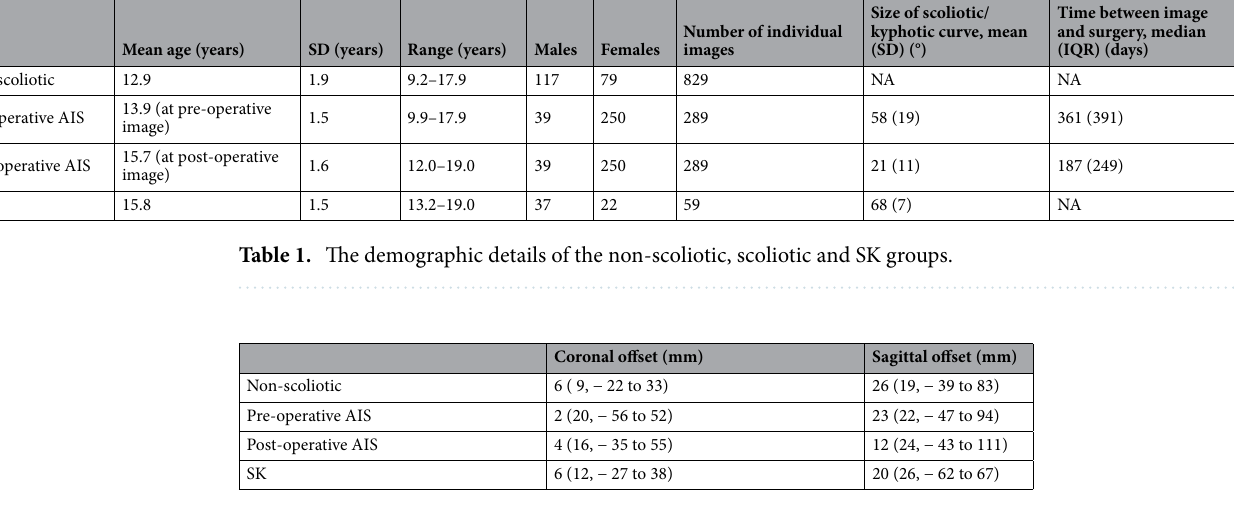
Table 2. The mean, standard deviation and range of the coronal and sagittal offsets in the non-scoliotic, scoliotic and SK groups. Please note that the images in the pre-operative and post-operative AIS groups are